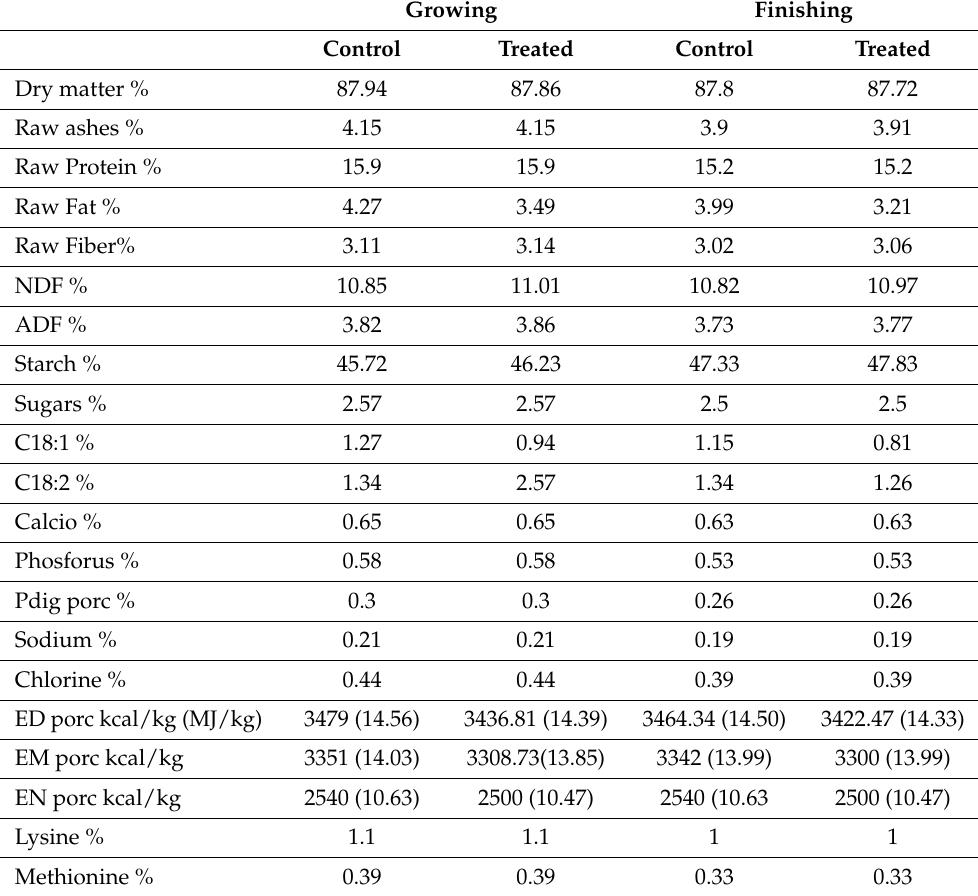
Table 2. Analytical values for growing and finishing feeds for each group. Growing